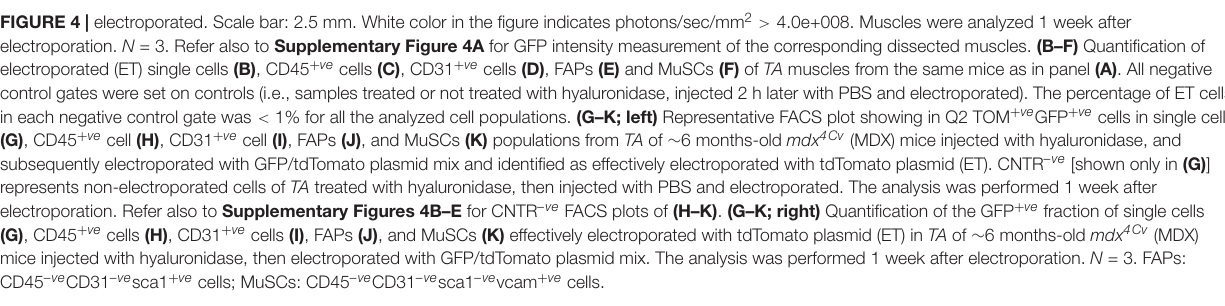
FIGURE 4 | electroporated. Scale bar: 2.5 mm. White color in the figure indicates photons/sec/mm 2 > 4.0e+008. Muscles were analyzed 1 week after electroporation. N = 3. Refer also to Supplementary Figure 4A for GFP intensity measurement of the corresponding dissected muscles. (B–F) Quantification of electroporated (ET) single cells (B) , CD45 + ve cells (C) , CD31 + ve cells (D) , FAPs (E) and MuSCs (F) of TA muscles from the same mice as in panel (A) . All negative control gates were set on controls (i.e., samples treated or not treated with hyaluronidase, injected 2 h later with PBS and electroporated). The percentage of ET cells in each negative control gate was < 1% for all the analyzed cell populations. (G–K; left) Representative FACS plot showing in Q2 TOM + ve GFP + ve cells in single cell (G) , CD45 + ve cell (H) , CD31 + ve cell (I) , FAPs (J) , and MuSCs (K) populations from TA of ∼ 6 months-old mdx 4Cv (MDX) mice injected with hyaluronidase, and subsequently electroporated with GFP/tdTomato plasmid mix and identified as effectively electroporated with tdTomato plasmid (ET). CNTR – ve [shown only in (G) ] represents non-electroporated cells of TA treated with hyaluronidase, then injected with PBS and electroporated. The analysis was performed 1 week after electroporation. Refer also to Supplementary Figures 4B–E for CNTR – ve FACS plots of (H–K) . (G–K; right) Quantification of the GFP + ve fraction of single cells (G) , CD45 + ve cells (H) , CD31 + ve cells (I) , FAPs (J) , and MuSCs (K) effectively electroporated with tdTomato plasmid (ET) in TA of ∼ 6 months-old mdx 4Cv (MDX) mice injected with hyaluronidase, then electroporated with GFP/tdTomato plasmid mix. The analysis was performed 1 week after electroporation. N = 3. FAPs: CD45 – ve CD31 – ve sca1 + ve cells; MuSCs: CD45 – ve CD31 – ve sca1 – ve vcam + ve